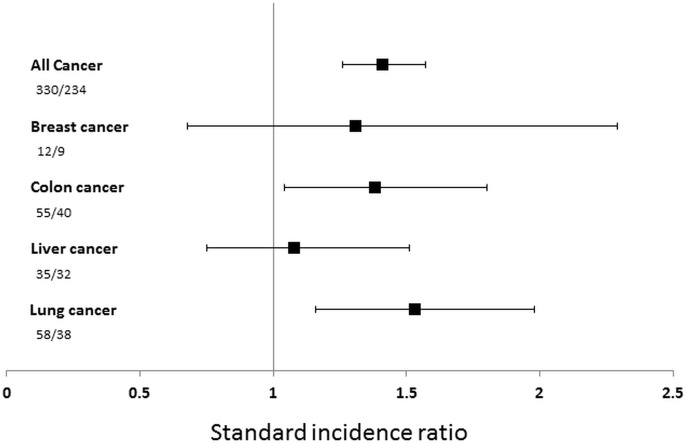
The standardized incidence ratio.The standardized incidence ratio and 95% confidence interval of all cancers and different types of cancer compared with the general population. Numbers shown are observed number of cancer cases/expected number of cancer cases.